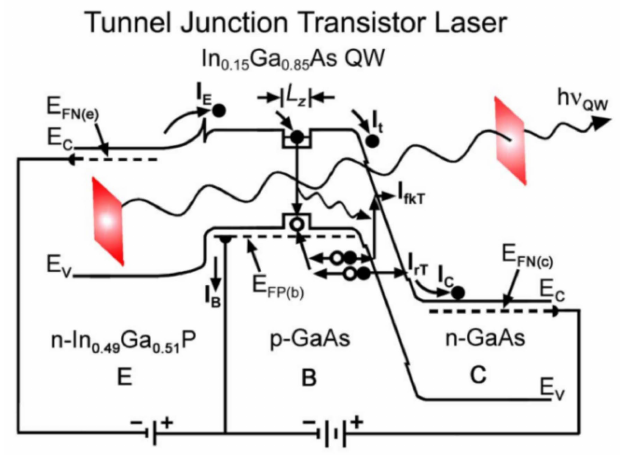
Figure 10. TJ–TL energy band and intracavity photon-assisted tunneling diagrams [61]. Reproduced from Ref. [61], with the permission of AIP